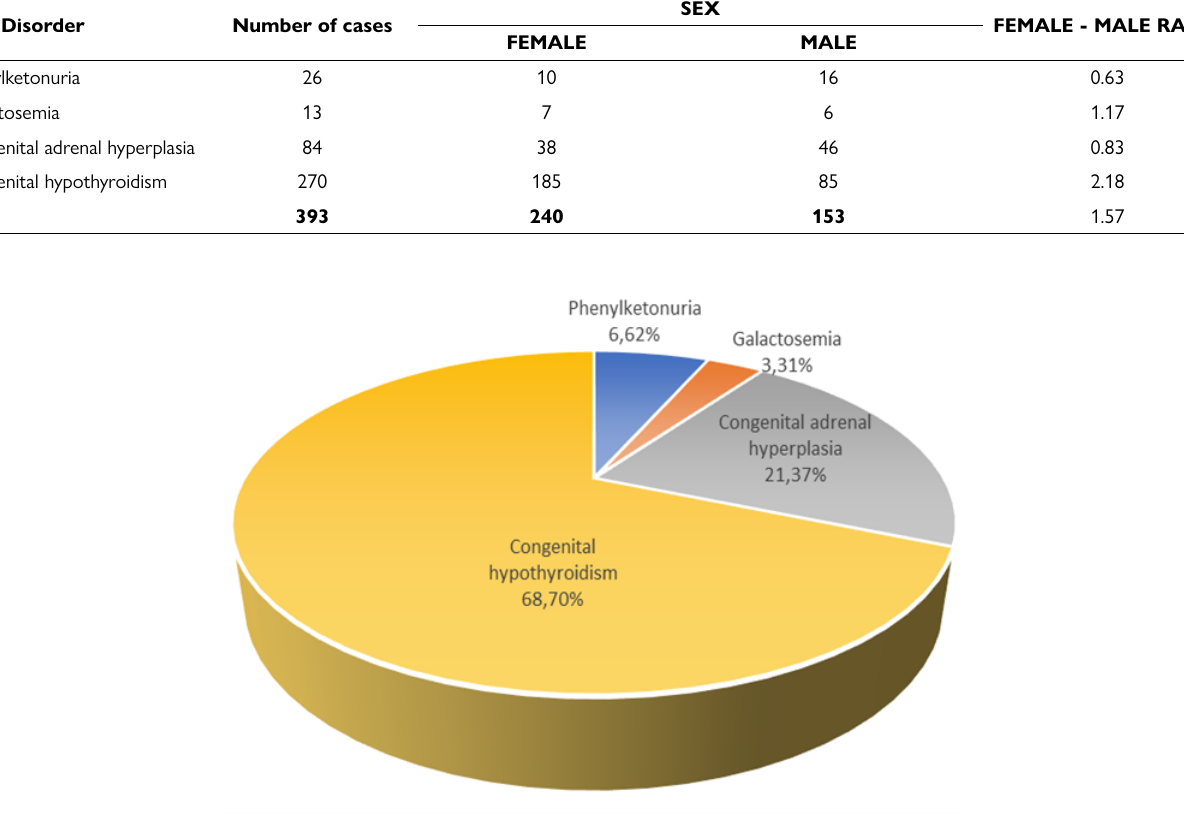
Figure 1. Cases diagnosed by the NBS Program between 2012 and 2019 in